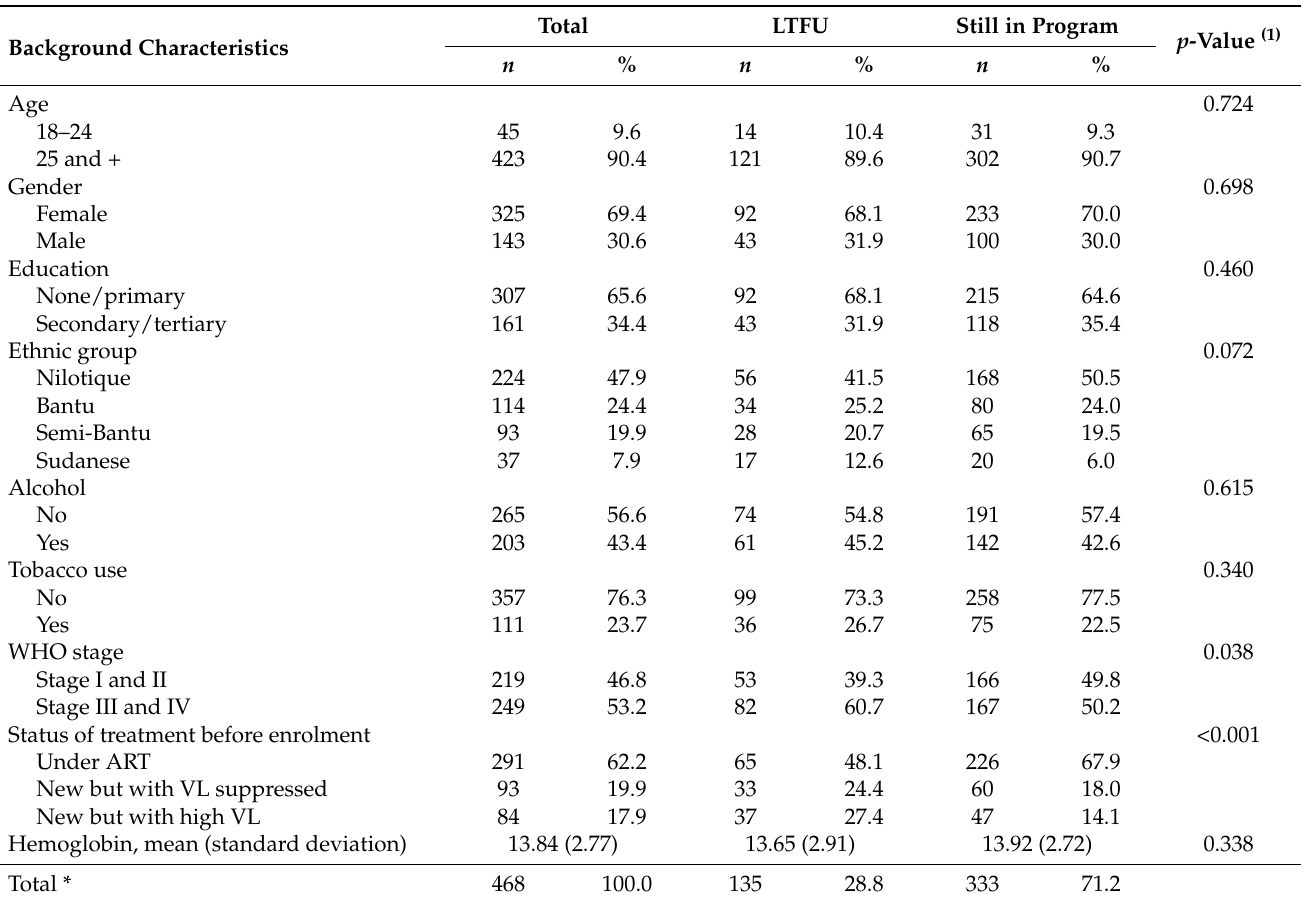
Table 1. Patient distribution of included first-time mothers and those lost to follow up by baseline characteristics,